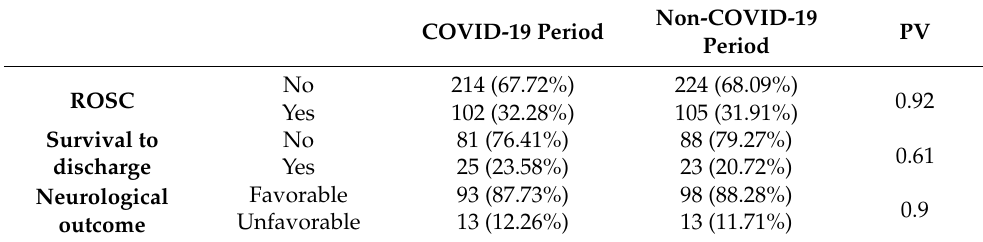
Table 7. Comparison between the first year of the COVID-19 pandemic and the examined years before in all three